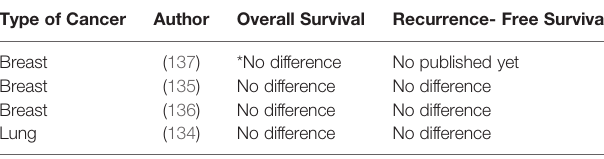
*Preliminary data from 1 year